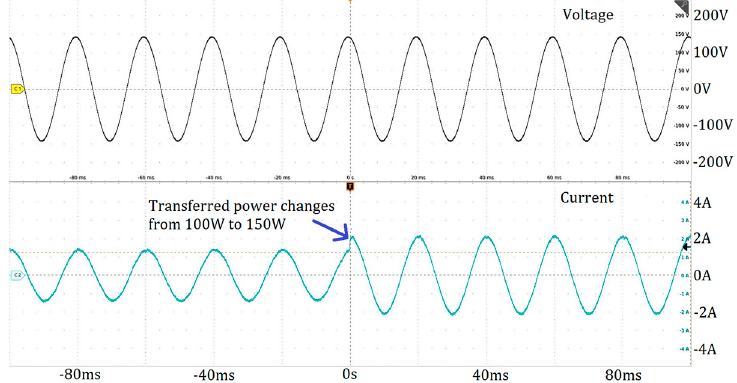
Figure 10. Responses of the grid-connected inverter when the transferred power changes from 100 W to 150 W.